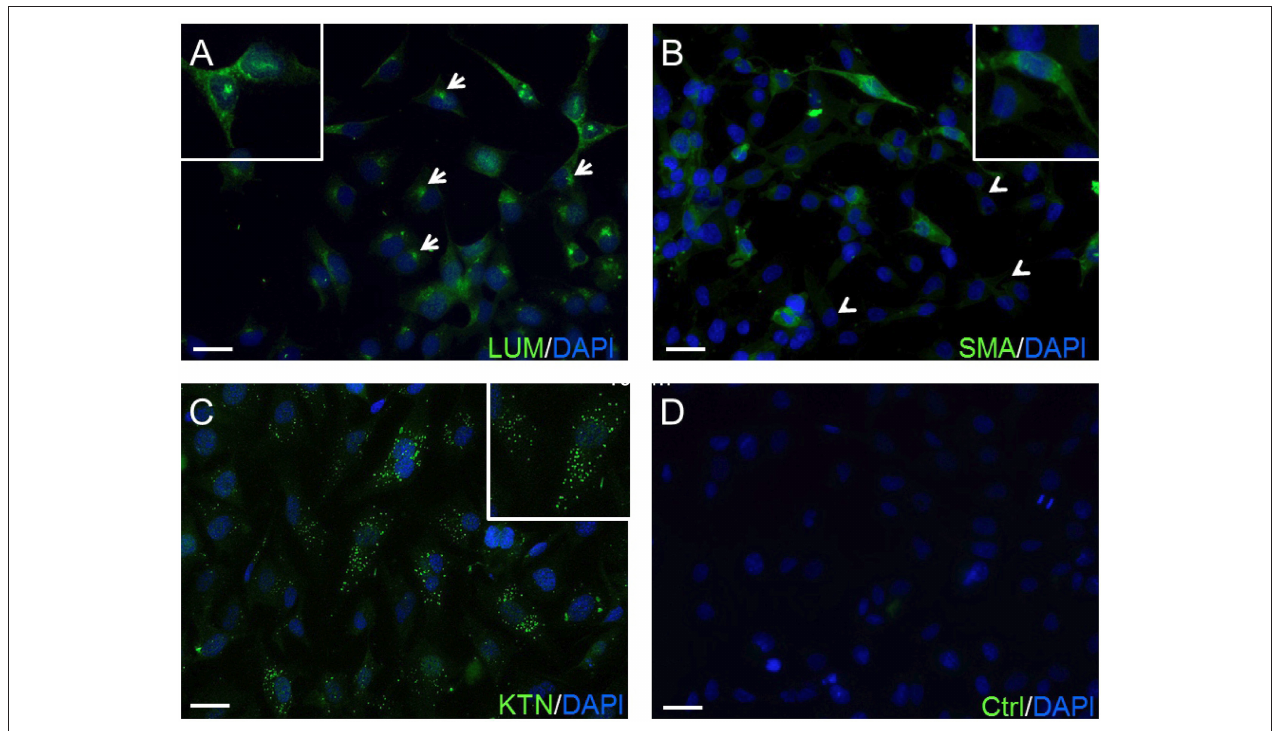
FIGURE 1 | Confirmation of HCK identity. (A) The green anti-LUM antibody immunofluorescent (IF) staining is delimited in the endoplasmic reticulum (arrows). (B) Anti- α -SMA antibody IF staining pattern. Their green staining pattern is less intense. Approximately 20–30% of the HCK cells have no IF signal (arrow heads). (C) IF green staining with anti-KTN antibody detected in all HCKs. (D) A negative control (Ctrl) omitted primary antibody and does not provide a specific IF signal. In all experiments, cell nuclei were counterstained with DAPI (blue) and pictures were merged. Pictures are representative of IF results from five different assays ( n = 5).